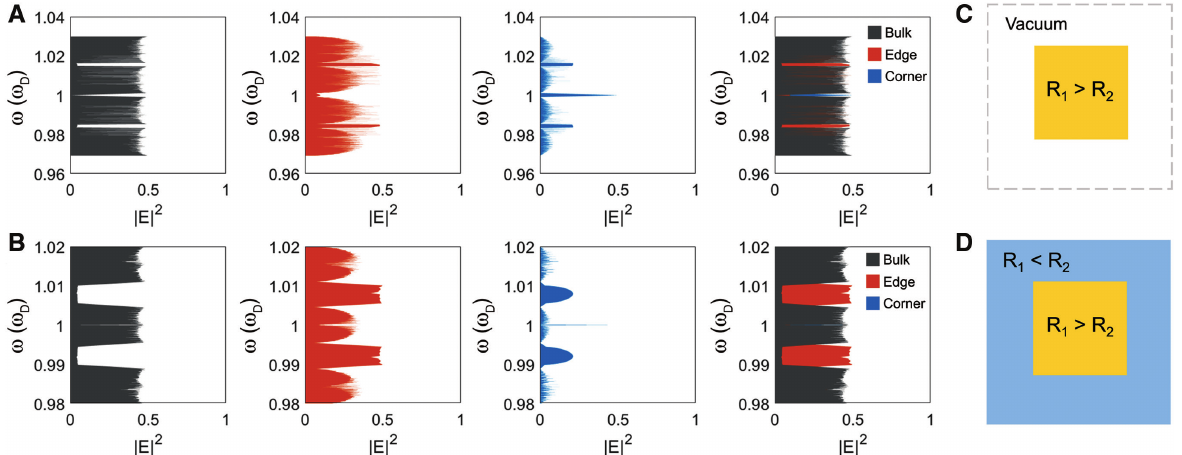
Figure 4: Spectra of the bulk, edge and corner modes and conceptual illustration for second-order topological phase in 2D SSH model. (A, B) Spectra of the bulk, edge, and corner modes of (A) in-plane and (B) out-of-plane polarization. Gray: bulk, Orange: edge, Blue: corner. x -Axis is set as an arbitrary unit and normalized to 0.5. (C–D) Illustrations of 2D SSH model supporting second-order topological phase for (C) in-plane and (D) out-of-plane polarization. Yellow: 2D SSH model with R (topologically